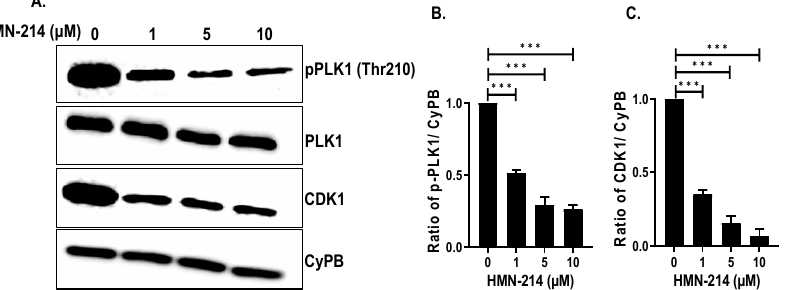
Figure 9. HMN-214 inhibits PLK1 activation. ( A ) Western blot analysis of PLK1, pPLK1 (Thr210), and CDK1 in response to HMN-214 treatment in SH-SY5Y cells. CyPB is used as loading control. ( B , C ) Densiometric analysis of ( B ) pPLK1 and ( C ) CDK1. *** p < 0.001.